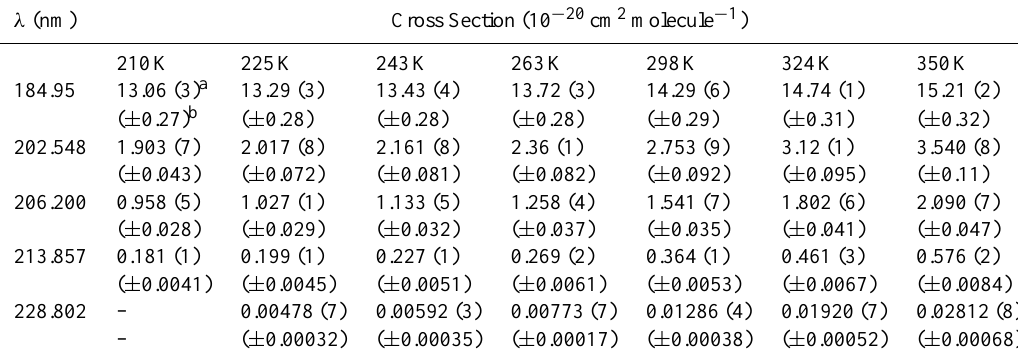
Table 1. UV absorption cross sections for N 2